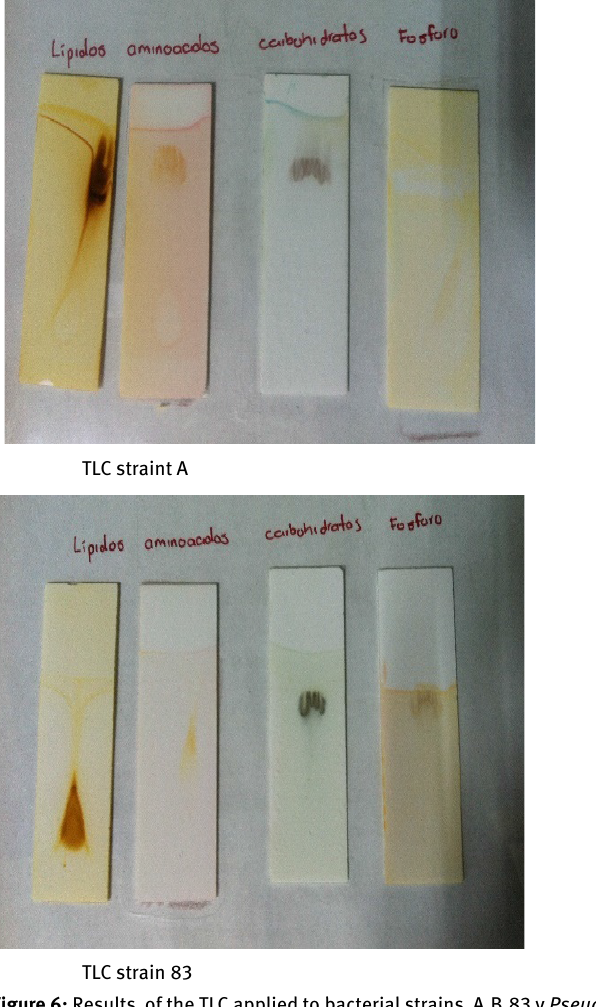
Figure 6: Results of the TLC applied to bacterial strains A,B,83 y Pseudomonas aeruginosa